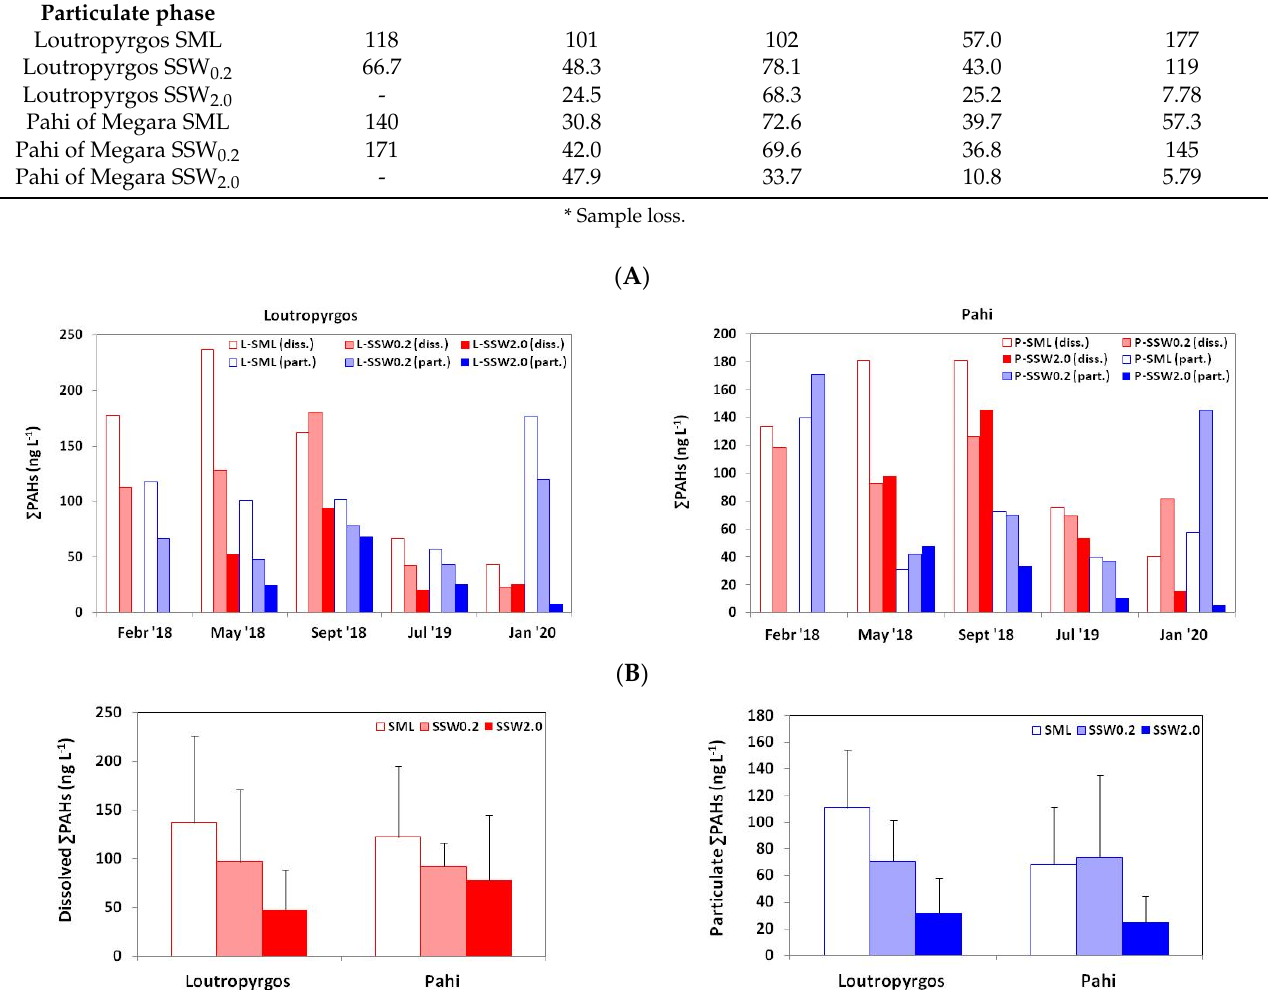
Figure 2. Concentrations of dissolved and particulate ∑ PAHs ( A ) during the samplings performed, ( B ) mean values for the different sampling sites.